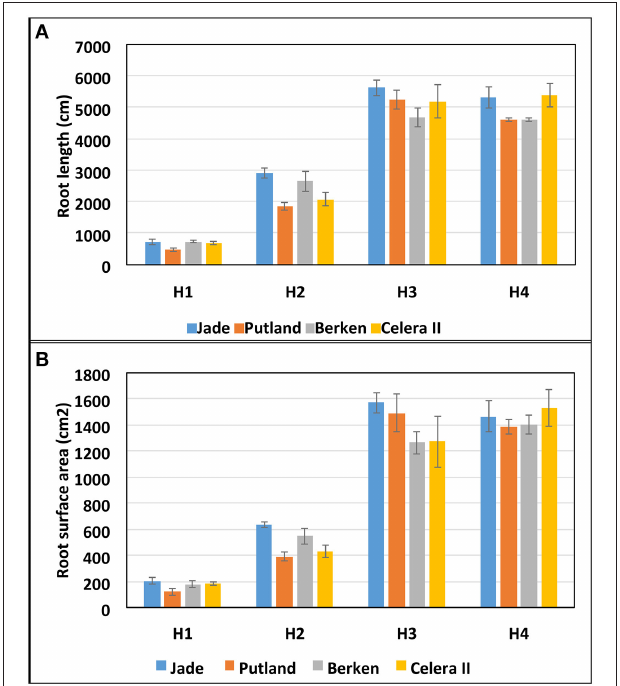
FIGURE 4 | Root morphometric measurements (A) total root length and (B) root surface area at four harvests (H1, H2, H3, and H4) for four mungbean varieties (Jade, Putland, Berken and Celera II). Bars represent standard error of